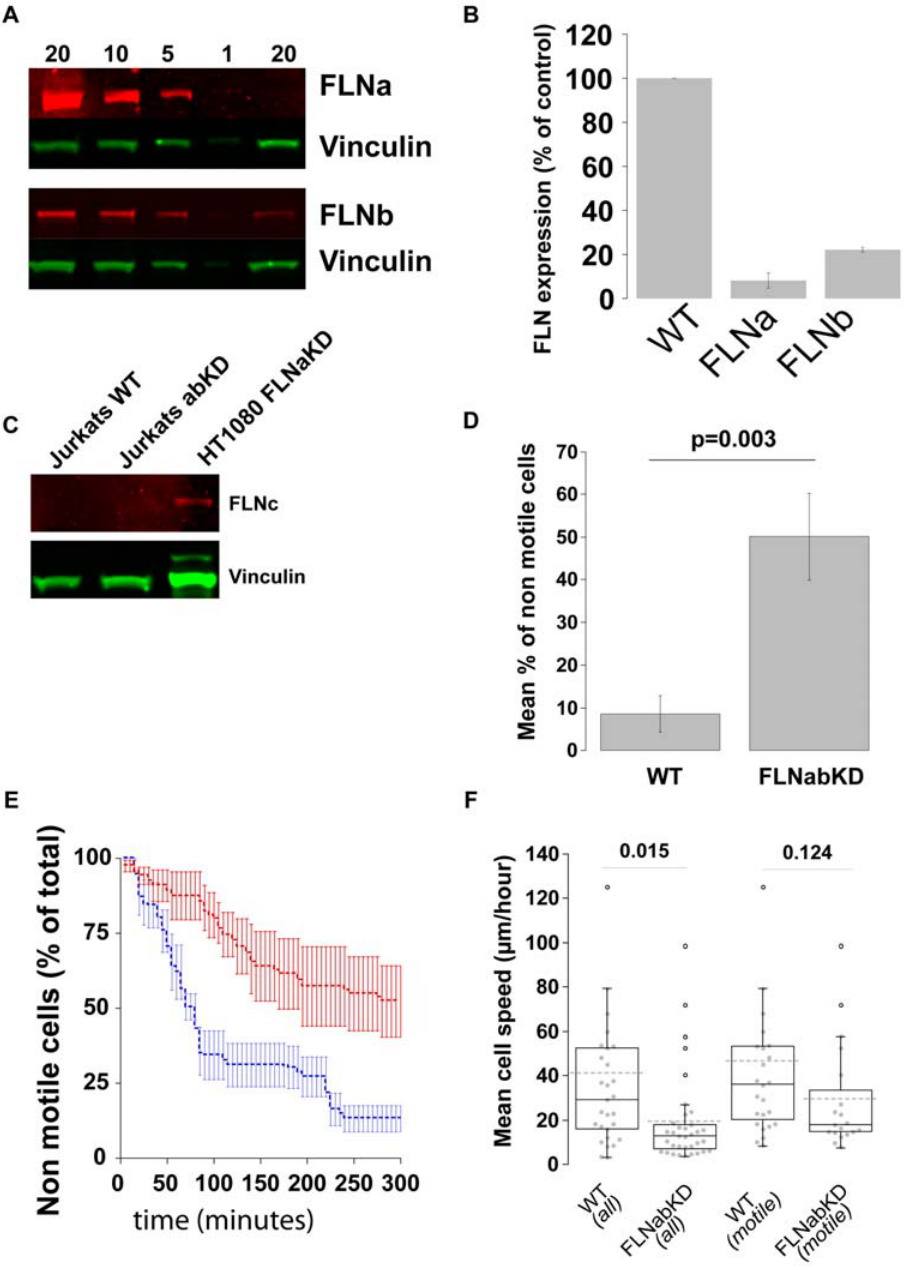
Figure 9. FLNs play a role in initiation of cell migration in Jurkat cells. A ) FLNa and FLNb protein expression was quantified comparing 20 m g of cell lysate prepared from Jurkat FLNabKD cells to a curve of cell lysates prepared from Jurkat WT lysates. Vinculin was used as loading control. B ) Quantification of FLNa and FLNb protein expression; bars show mean value normalized to control 6 SEM (n=4). C ) 20 m g of a cell lysate from Jurkat WT or Jurkat FLNabKD was probed for FLNc content, 20 m g of lysate from HT1080 FLNabKD cells was used as positive control. D ) Percent of non-motile cells in the time-lapse recording expressed as mean 6 SEM (from 6 independent experiments). E ) Percent of non-motile cells were analysed at each time point in 5 experiments and the average 6 SEM is plotted. Blue line shows Jurkat WT cells red line Jurkat FLNabKD cells. F ) Speed of Jurkat WT and FLNabKD cells: total population (left) or migratory population (right). (Sample size: WT all=29; FLNabKD all=35; WT motile=25; FLNabKD motile=19; from 6 independent experiments).